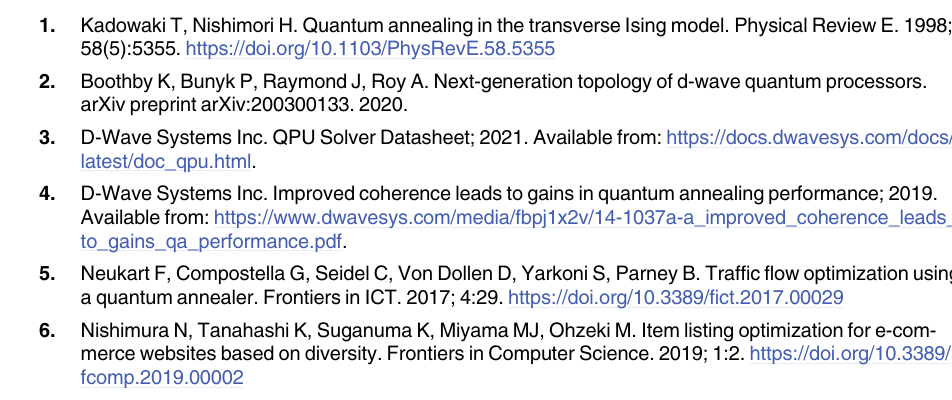
S1 Table. Tuning chain strength parameters. We solved Eq (12) using an annealing time of 50 μ s and considering 10000 samples. This table shows the percentage of feasible solutions for each chain strength parameter. “NaN” indicates that we did not conduct an experiment for this chain strength parameter. Bold letters indicate the highest